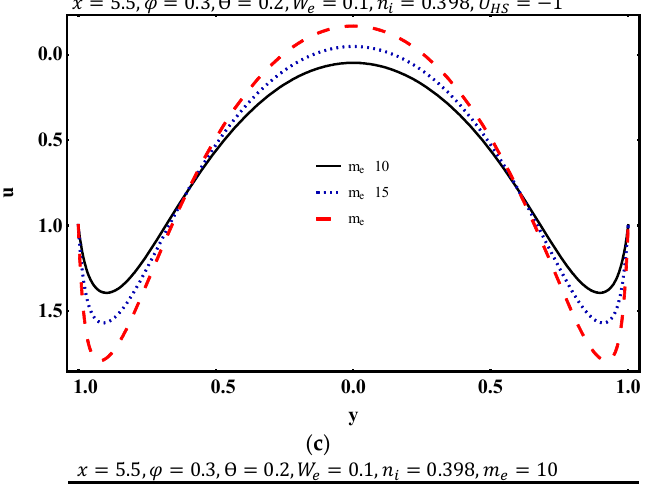
e ; ( b ) n i ; ( c ) m e ; ( d ) U HS ; ( e ) θ